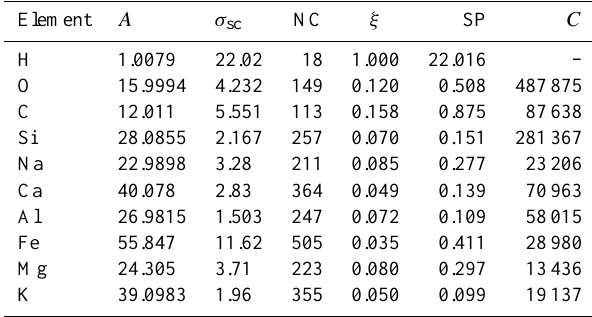
Table 1. Nuclear properties of ten elements contributing most to macroscopic scattering cross-section in terrestrial rocks. Key: A – atomic mass (gmole − 1 ) ; σ – elastic scattering cross-section (barns; 1barn=10 − 24 cm 2 ); H from Fig. 4.6 in Krane, 1988); other ele- ments from Table 1 in Sears (1992); NC – number of collisions to thermalize a 1–2MeV neutron (calculated using Eq. 12.8 in Krane, 1988); ξ – average log decrement of energy per neutron